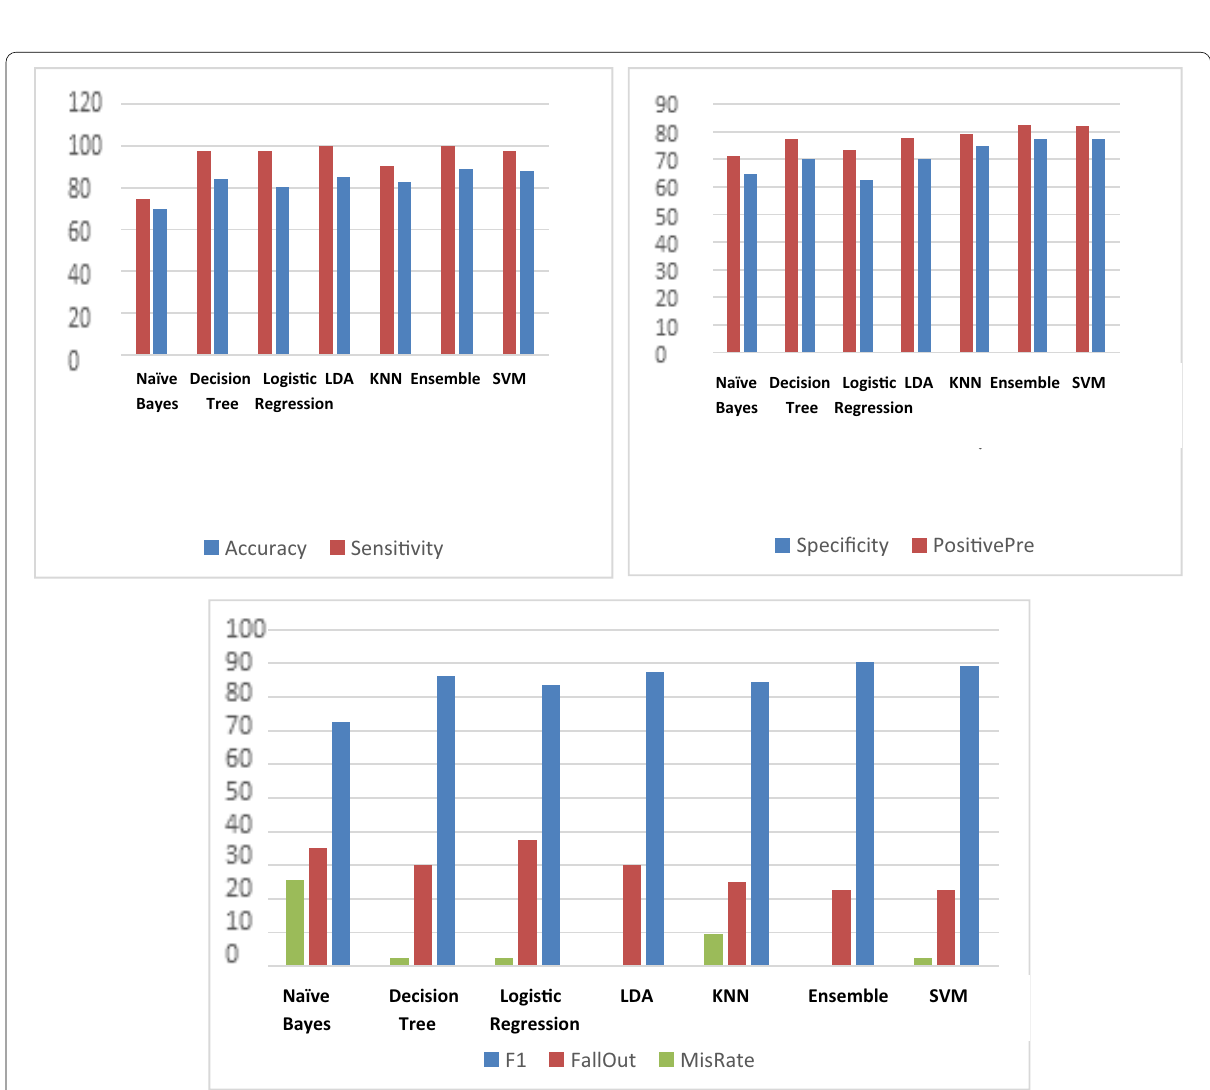
Fig. 5 Evaluation of the metric parameters for the seven classifiers of the continuous case testing